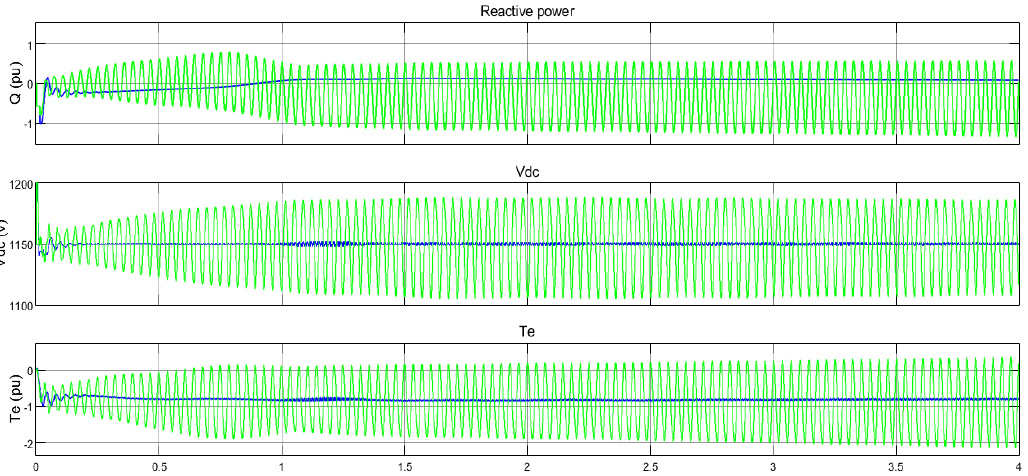
Figure 12. Damping of capacitor voltage, reactive power, and electrical torque in k = 75%, v = 7 m/s with new FLWADC and time delay equal to 350 ms in comparison without control.